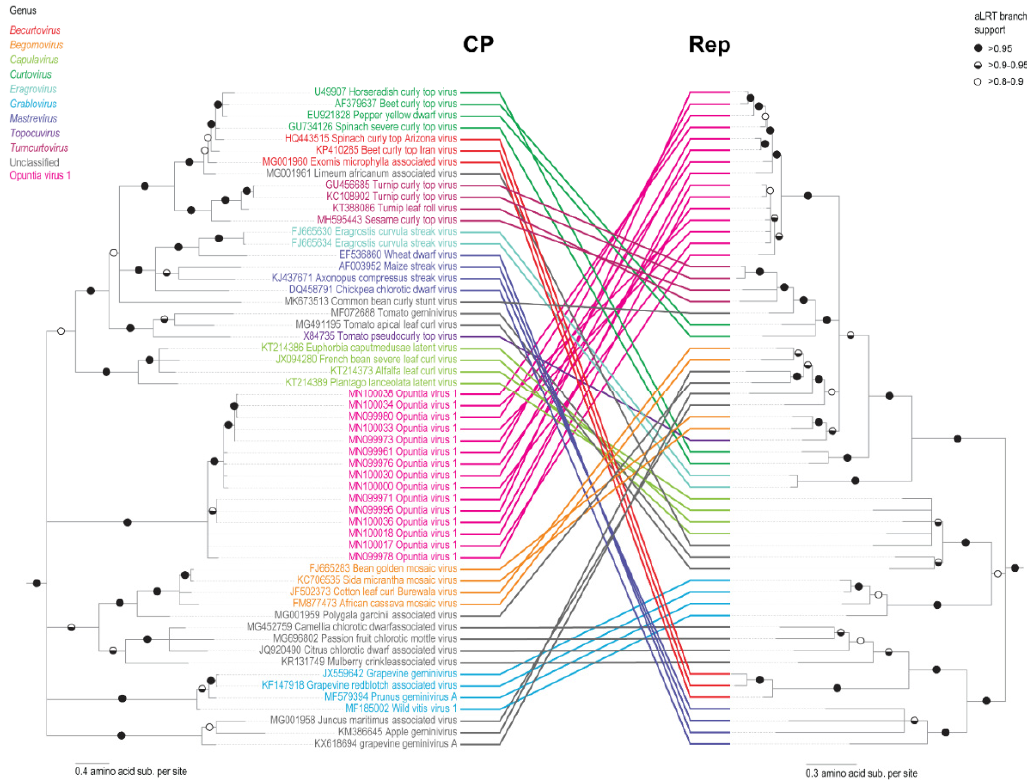
Figure 2. Maximum Likelihood (ML) phylogenetic trees of the Rep and CP amino acid sequences of the representative 15 genotypes of OpV1 together with other geminiviruses. Branches with aLRT support < 0.8 are collapsed and both trees were rooted with genomovirus [79] sequences.